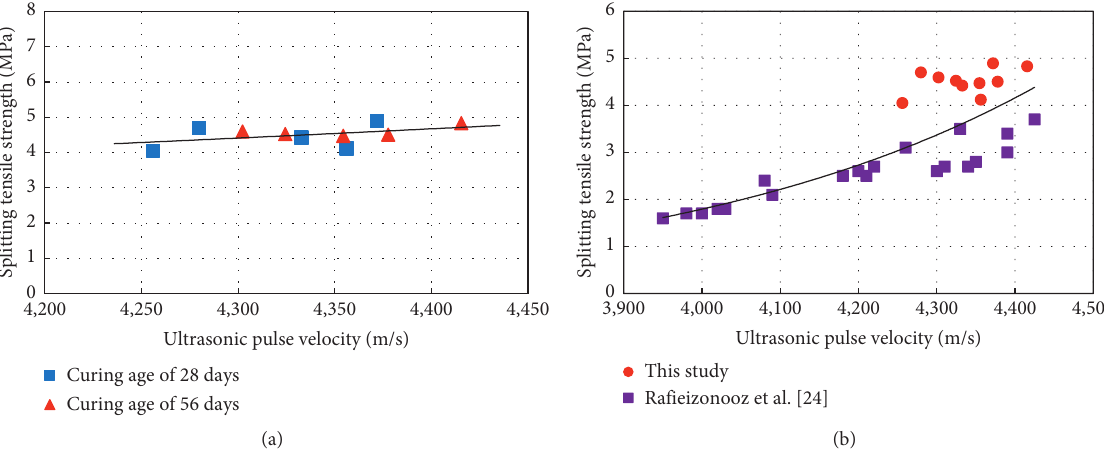
Figure 14: Relationship between the splitting tensile strength and ultrasonic pulse velocity. (a) Test results in this study. (b) Test results in this study and previous study.